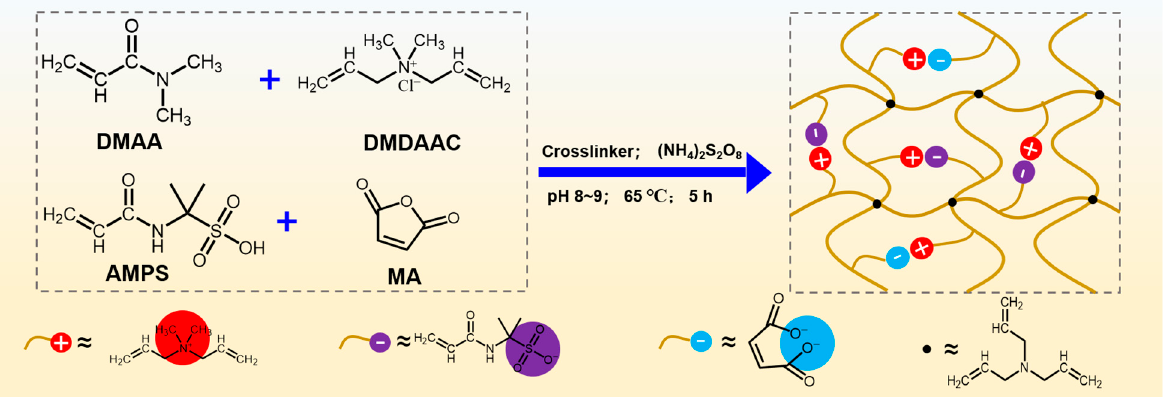
Figure 1. The synthesis procedure and structural formula of DDAM.